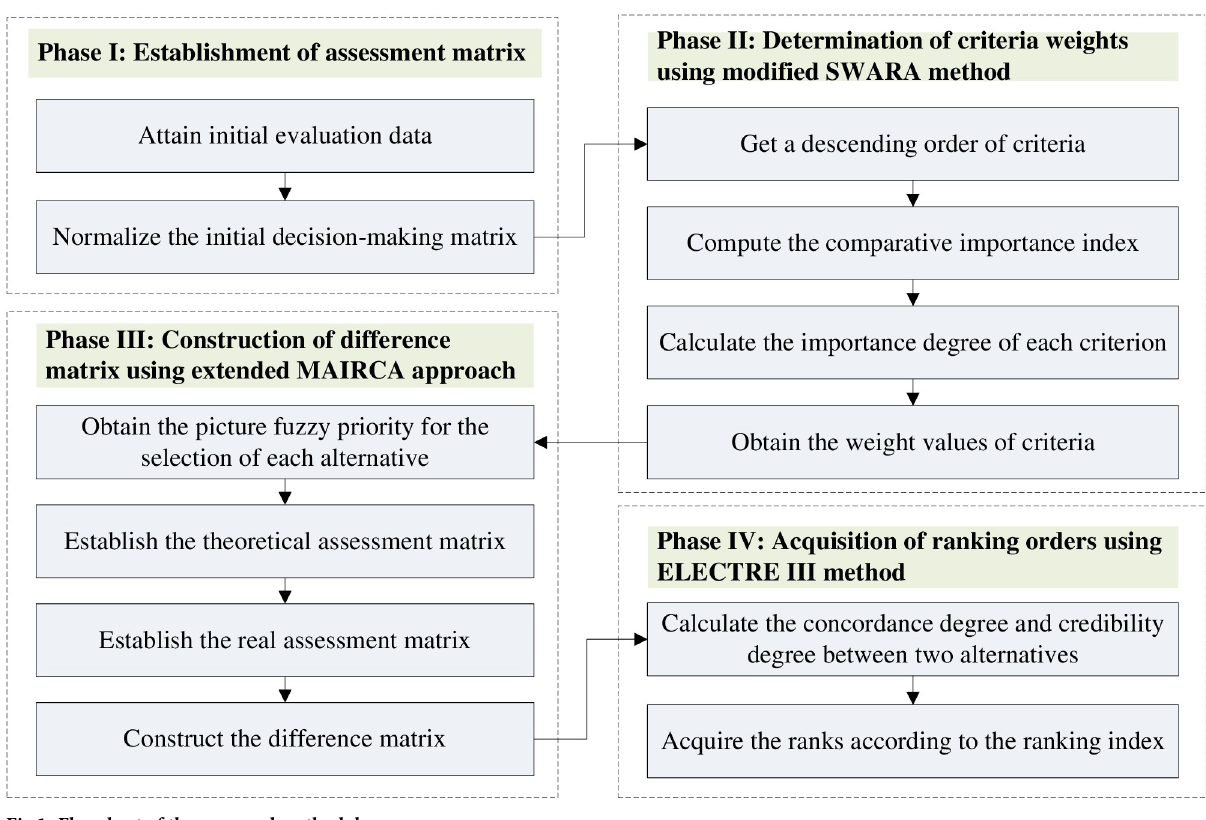
Fig 1. Flowchart of the proposed